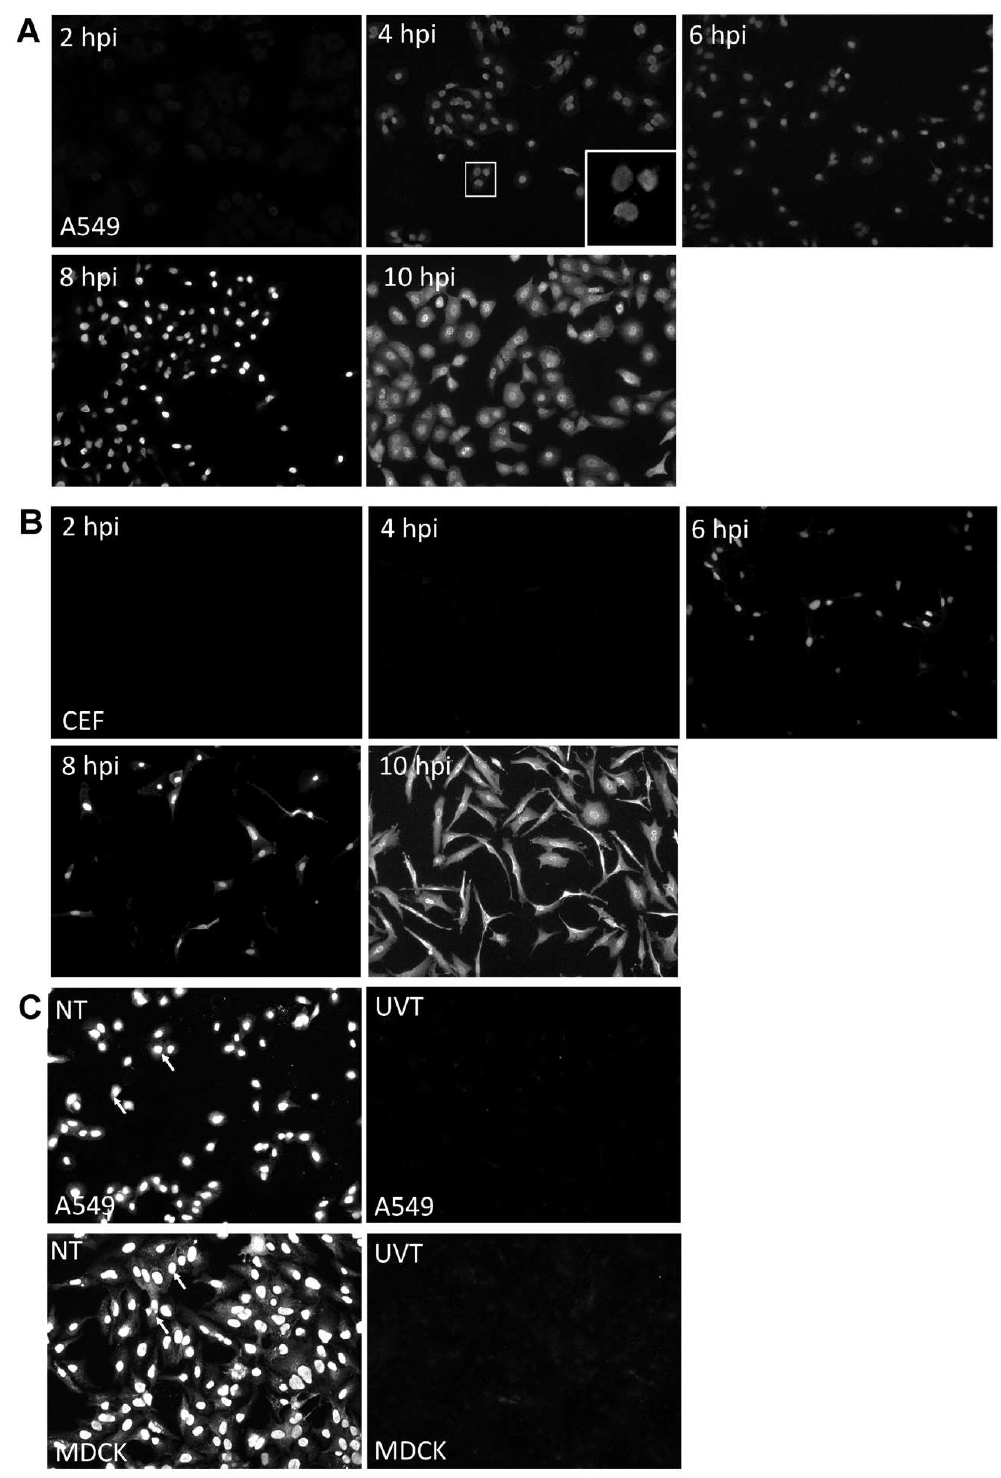
Figure 1. Examination of A549 cells, chick embryo fibroblast (CEF) and Madin-Darby canine kidney (MDCK) cells infected with H7N9 virus. ( A ) A549 cells and ( B ) CEF cells were H7N9 virus-infected at MOI of 5 and at 2,4,6,8 and 10 hours post-infection (hpi). The infected cells were stained with anti-influenza A virus and examined using immunofluorescence (IF) microscopy (objective × 40 magnification). The insert showing the virus-infected A549 cells at 4 hpi is an image at higher magnification. ( C ) A549 and MDCK cells were infected with untreated (NT) and UV-treated H7N9 virus (UVT) at MOI of 5. At 10 hpi, all cells were stained with anti-influenza A virus and examined using IF microscopy (objective × 40